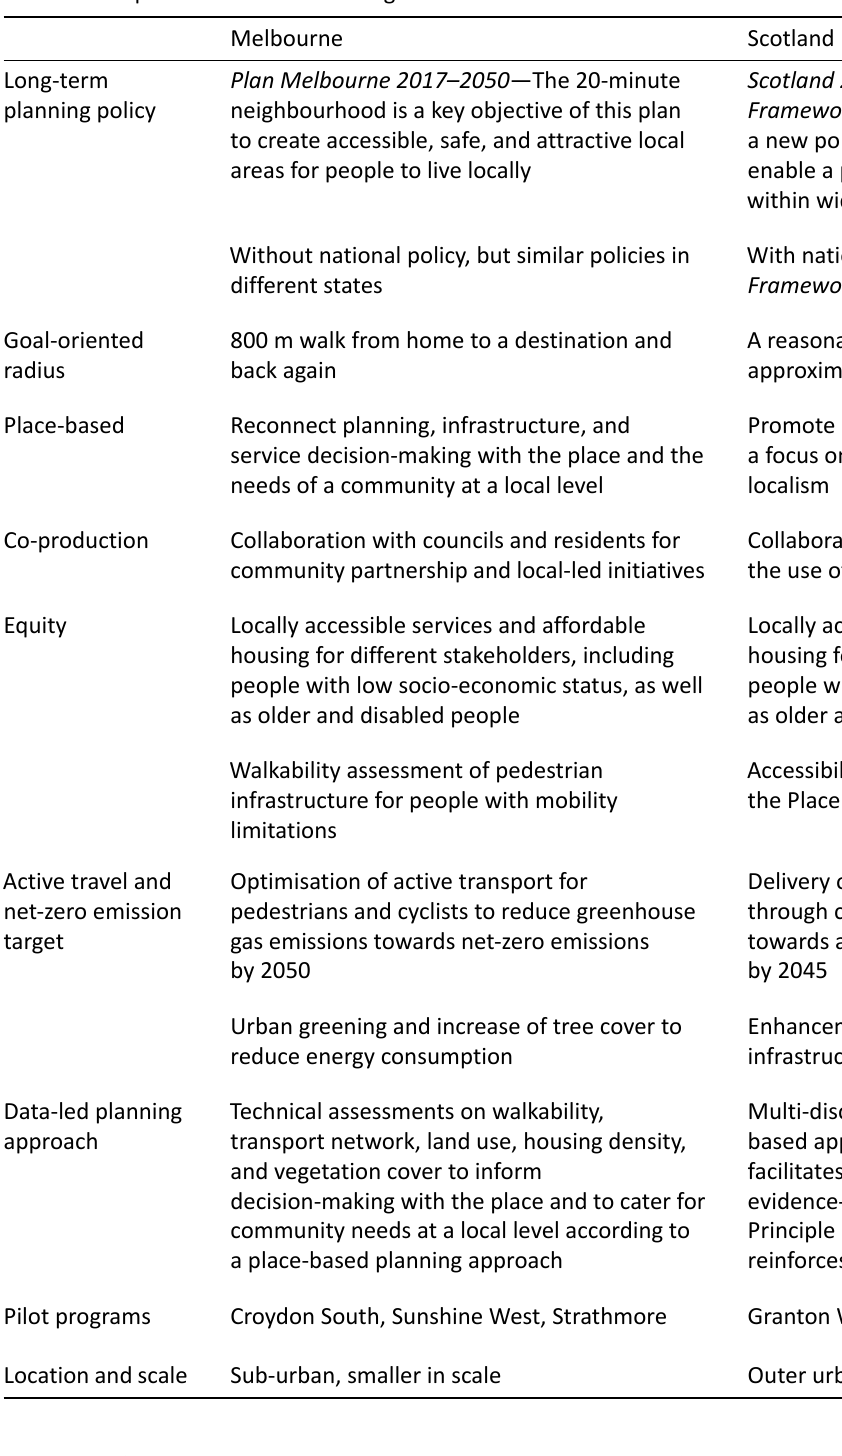
Table 1. Comparison of 20‐minute neighbourhoods in Melbourne and